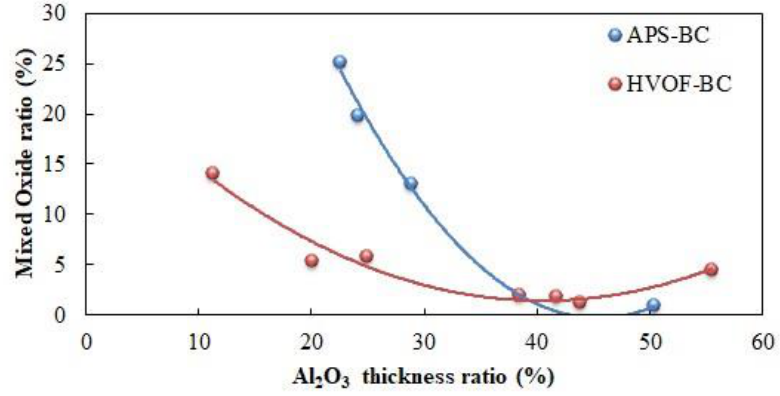
Figure 3. Wide view image of SEM micrograph, of isothermal ( a ) A100h, and ( b ) H100h and thermal cyclic test ( c ) A5c, ( d ) A10c, and ( e ) H1080c.